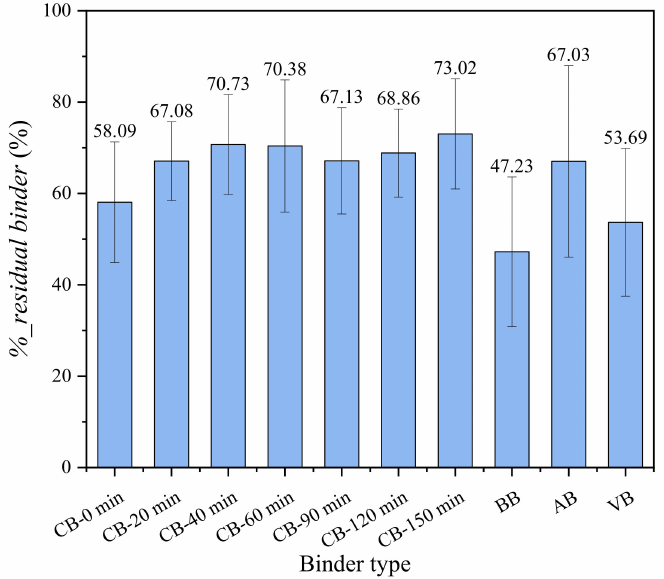
Figure 15. Results of binders-aggregate system with various thermostatic treatments.